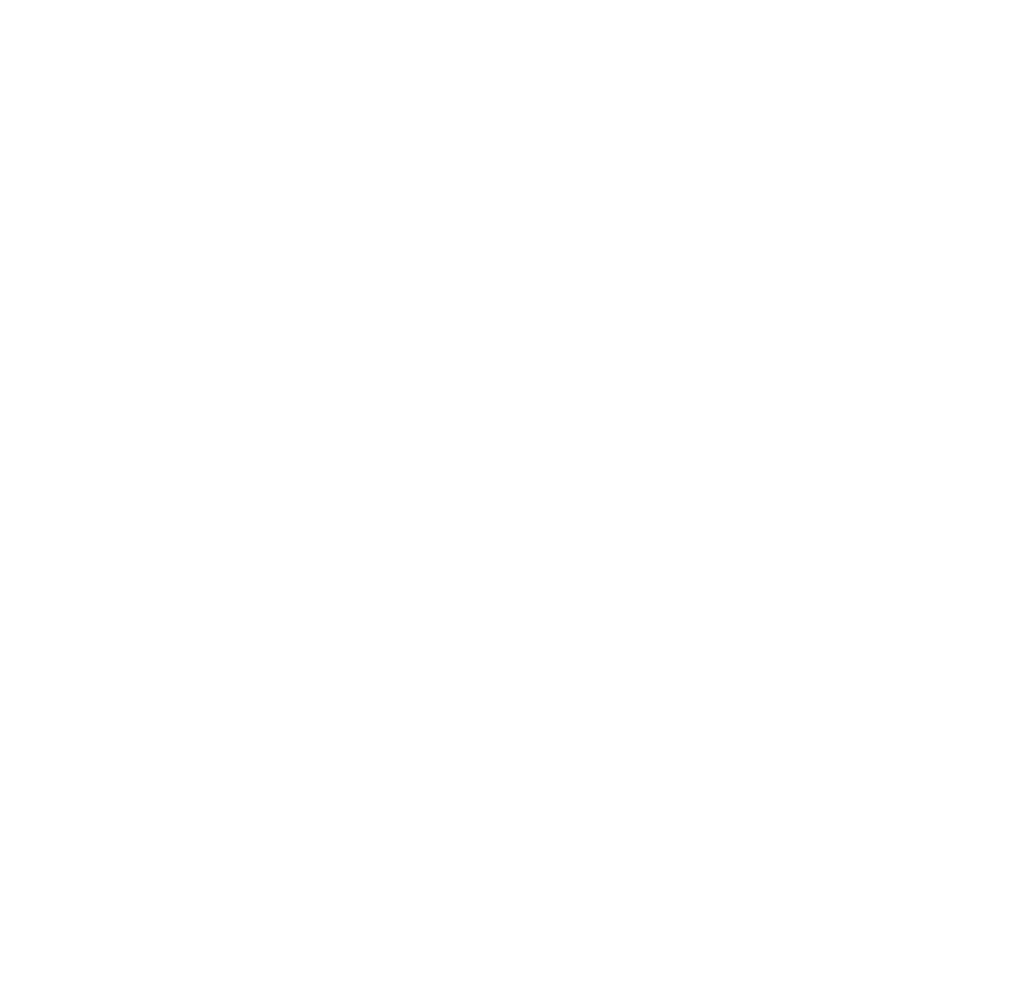
Figure 3. Risk of bias summary. (Green: low risk; Yellow: unclear risk; Red: high risk) [33 – 42] .